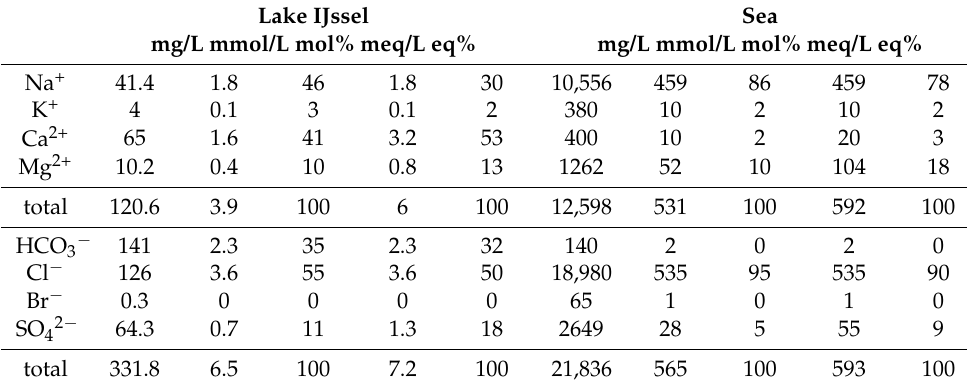
Table 1. Ionic composition of water from the Lake IJssel [21] and the North Sea